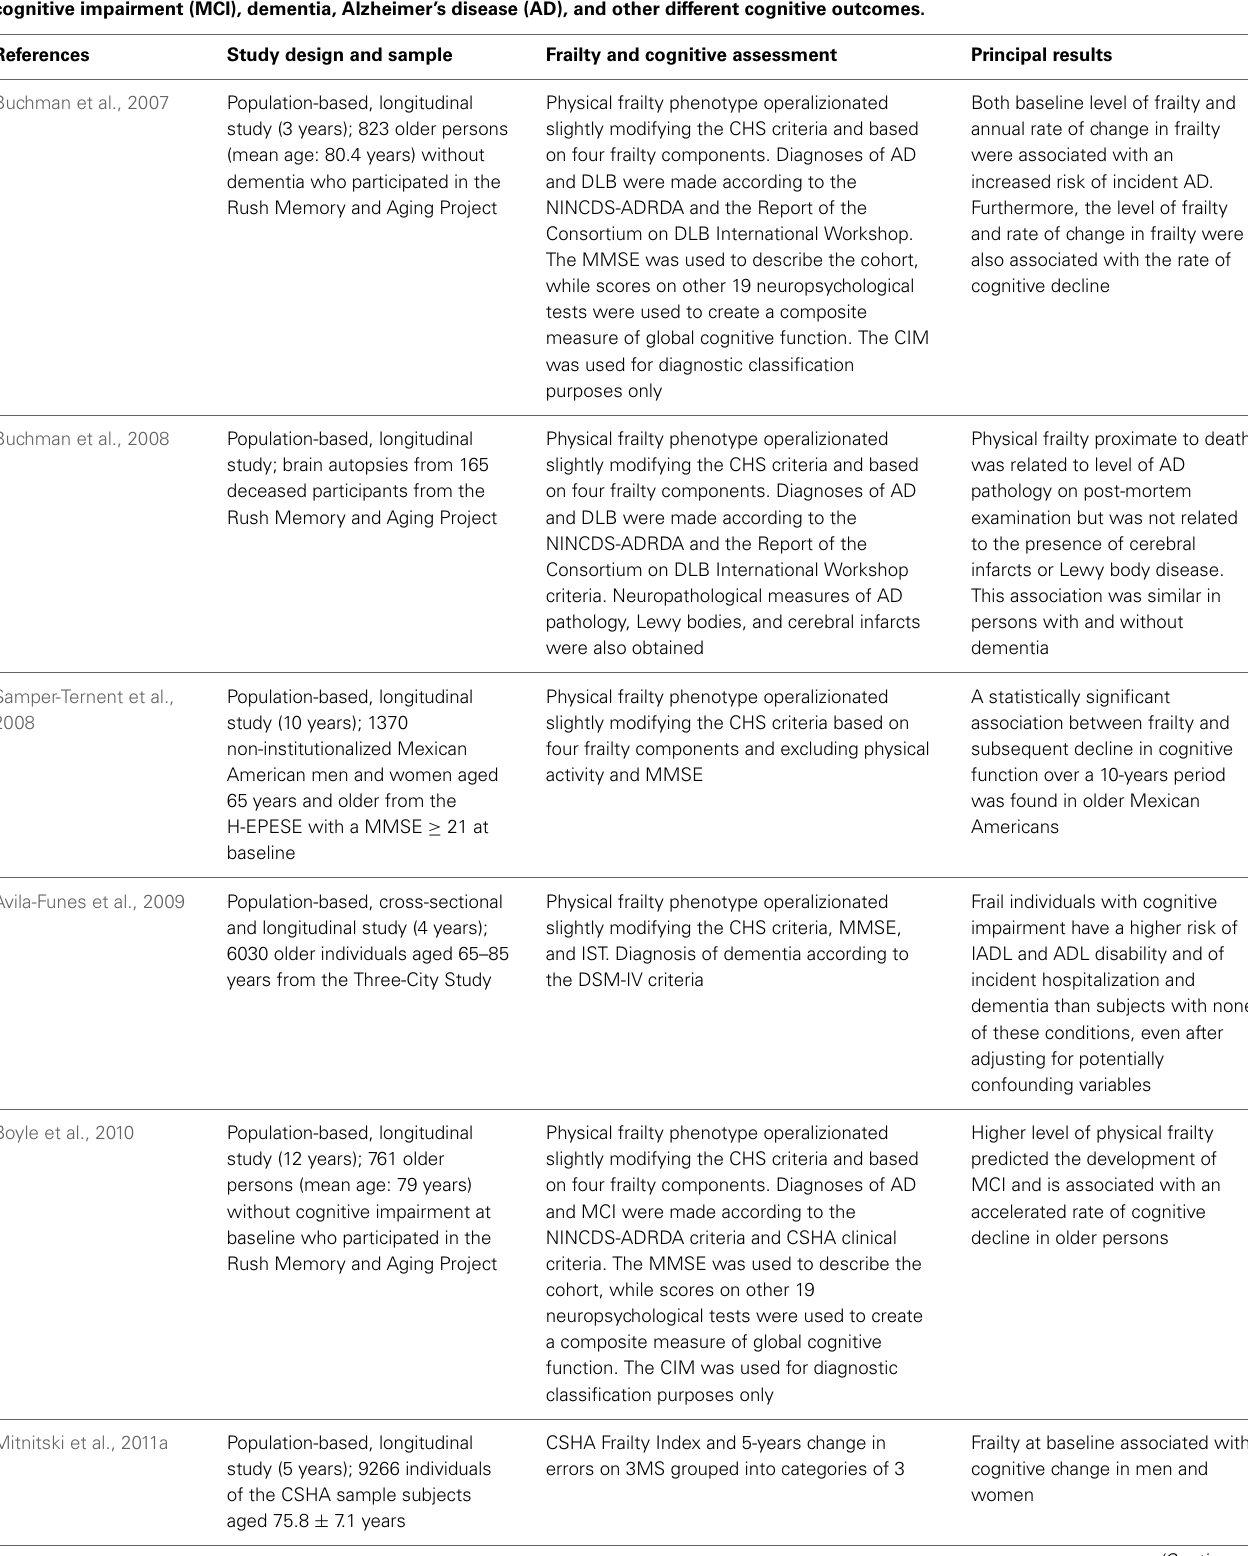
Table 1 | Principal population-based studies on the association of deficit accumulation/multidimensional operational definition of frailty, frailty instruments, and physical/phenotypic/biological operational definition of frailty with late-life cognitive impairment and decline, mild cognitive impairment (MCI), dementia, Alzheimer’s disease (AD), and other different cognitive